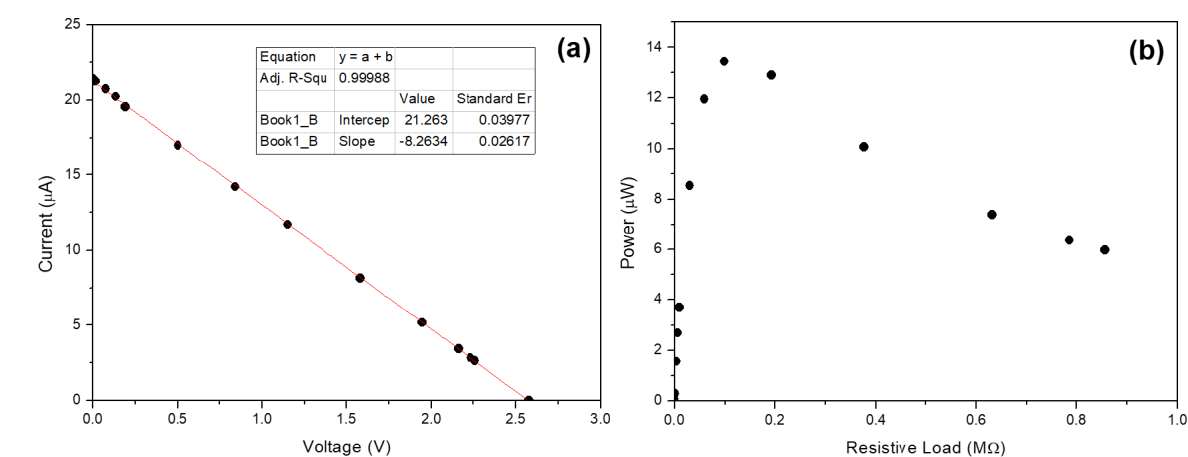
Figure 6. I-V characteristics of the square-wave voltage source ( a ) and its corresponding power curve ( b ).